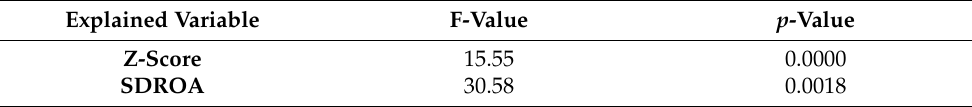
Table A5. Wald test (Fintech 1).